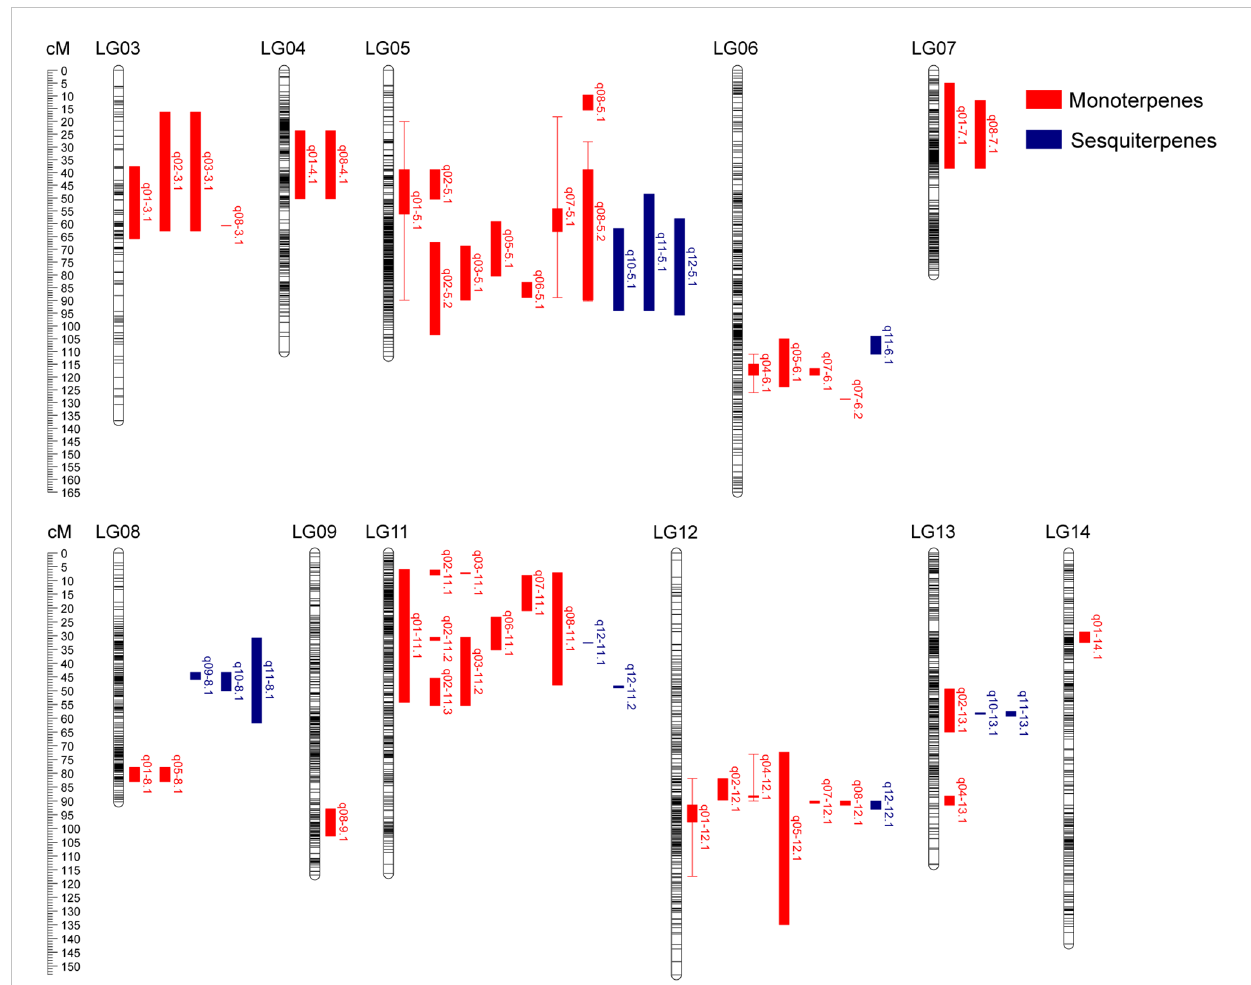
FIGURE 3 Distribution of QTL associated with volatile terpene contents identi fi ed in the ‘ HD ’ × ‘ JX ’ F 1 population. QTL intervals are shown on the right of linkage groups, represented by bars of different color (monoterpenes, red; sesquiterpenes,